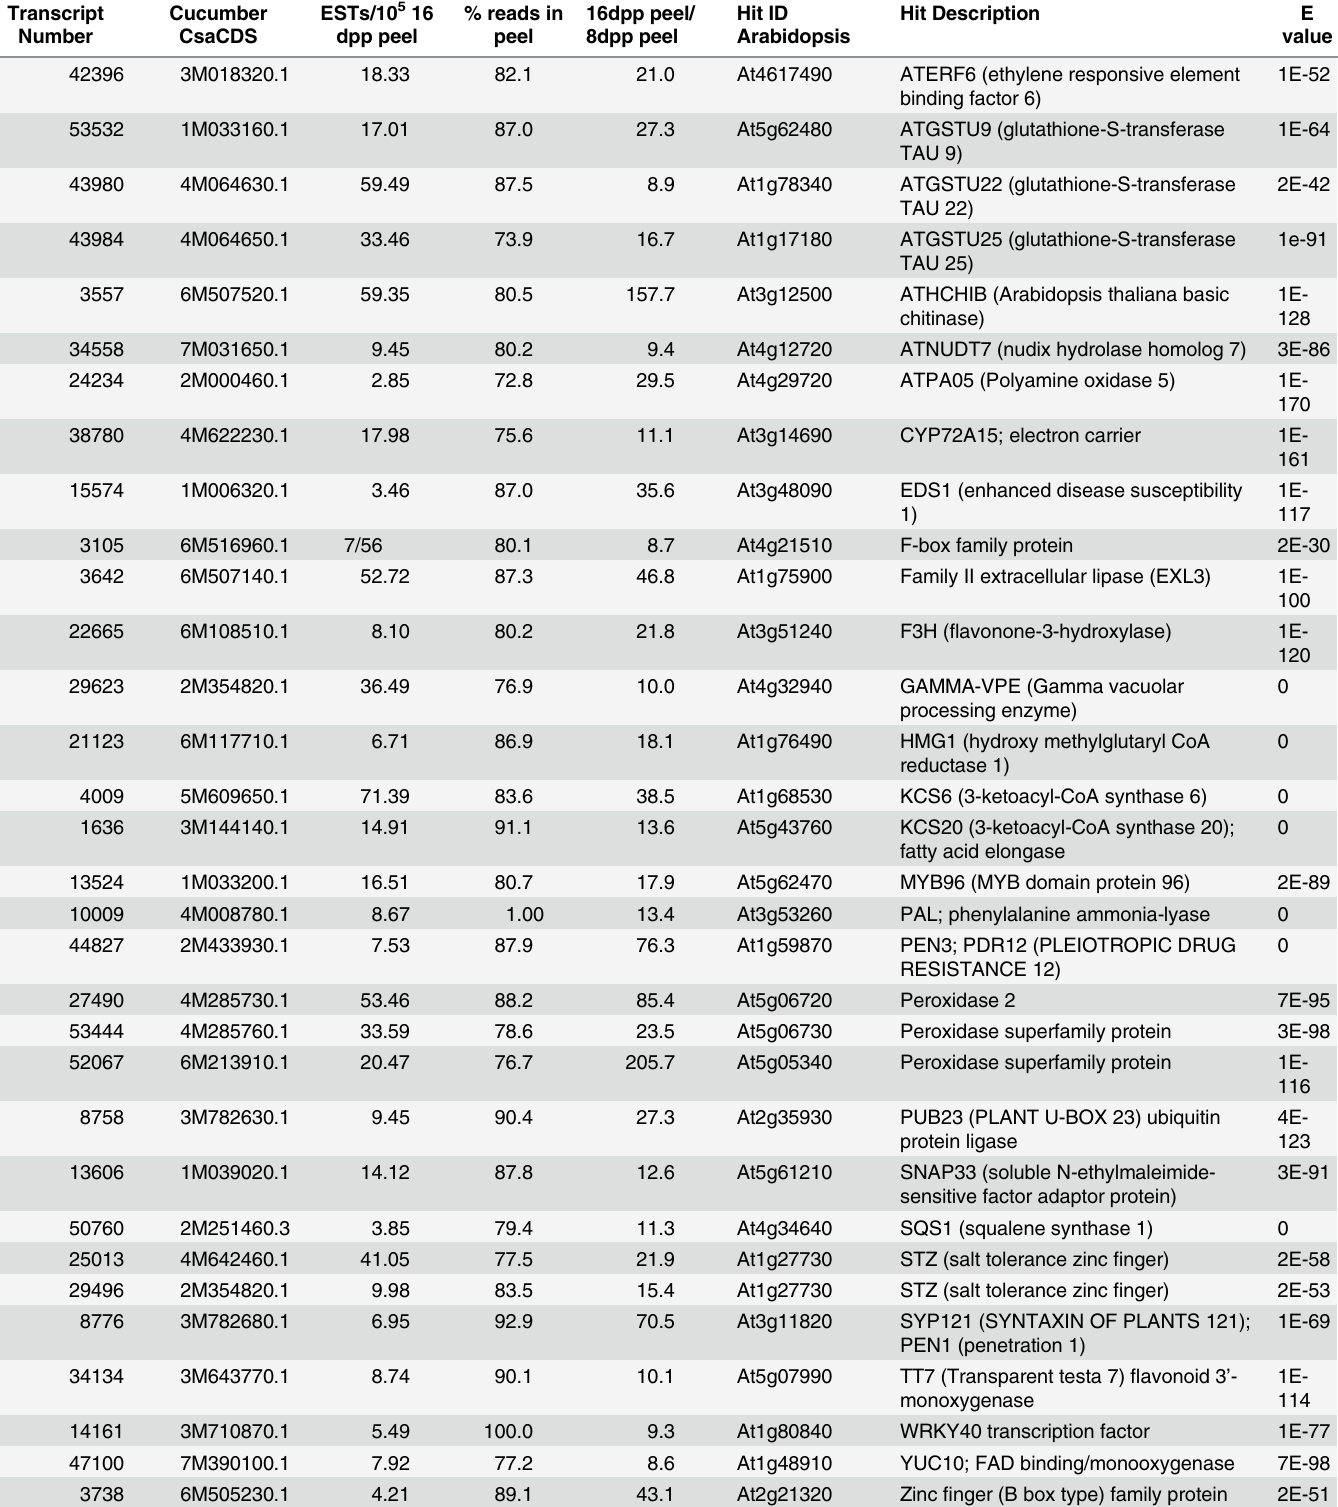
Table 3. Putative pathogen defense-associated transcripts preferentially expressed in cucumber fruit peel at 16 days post pollination. Transcript